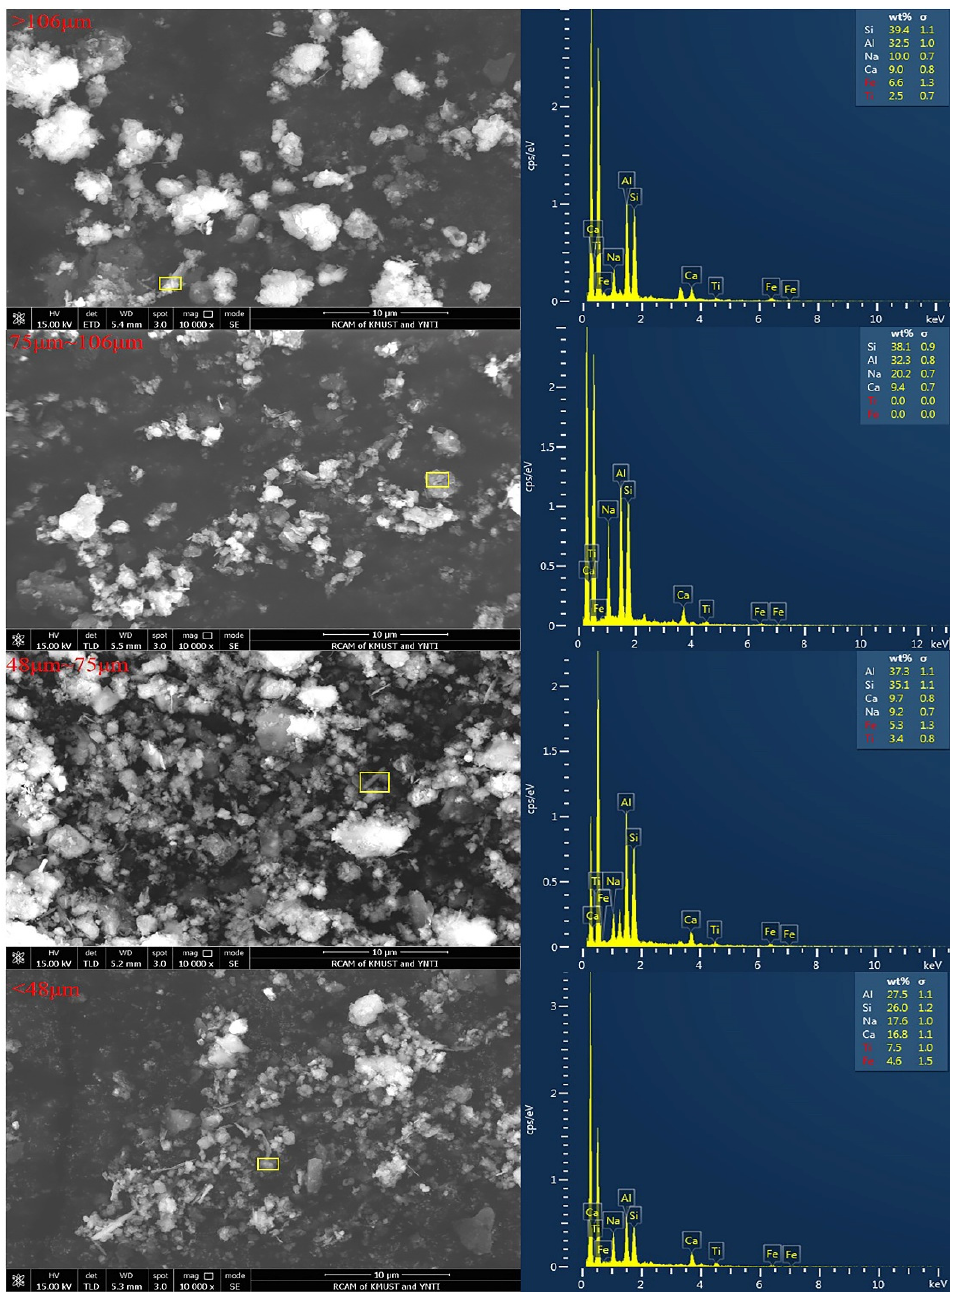
Figure 5. SEM-EDS analysis of red mud with different particle size.